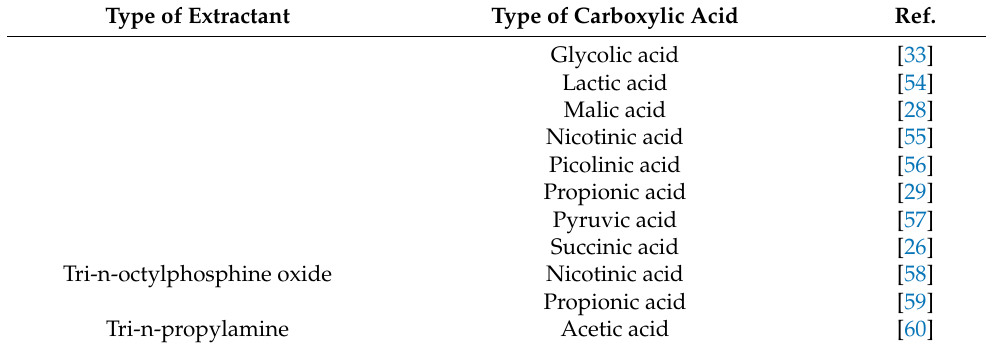
Glycolic acid [33] Lactic acid [54] Malic acid Nicotinic acid Picolinic acid Propionic acid Pyruvic acid